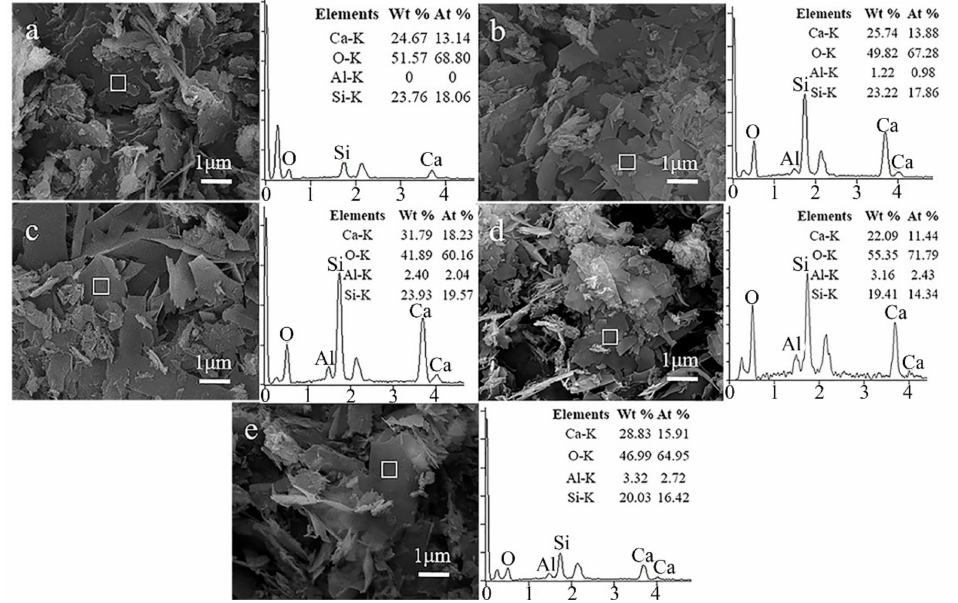
Figure 2. SEM–EDS images of hydrothermal synthesized Al-tobermorite with various Al / (Al + Si) molar ratios. (( a ): Al / (Al + Si) = 0, ( b ): Al / (Al + Si) = 0.05, ( c ): Al / (Al + Si) = 0.1, ( d ): Al / (Al + Si) = 0.15, and ( e ): Al / (Al + Si) =